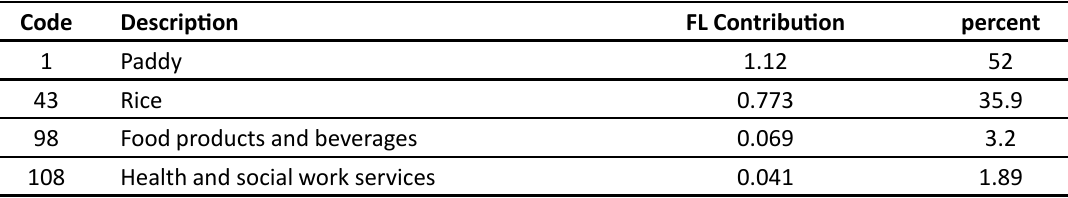
Table 3: The FiveMain Contributors to BL Rice